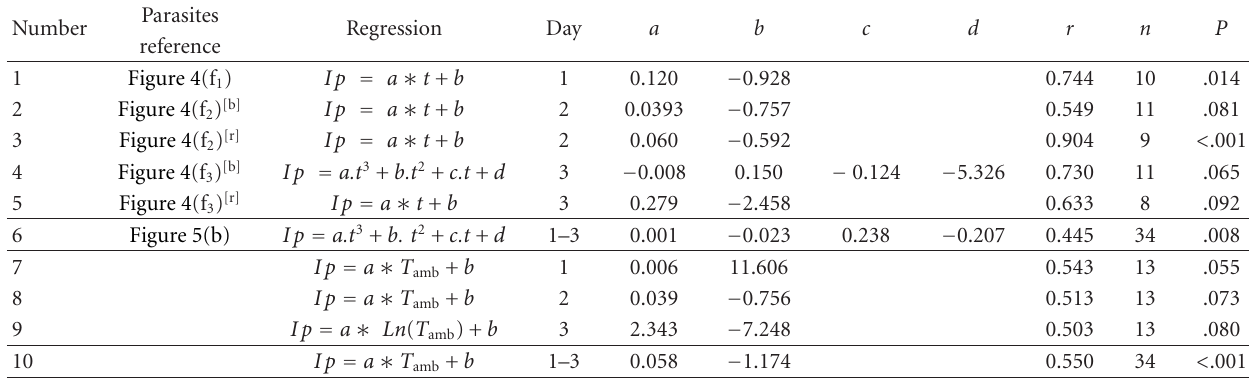
Table 2: Regression functions for the activities of parasites infesting Halictus scabiosae nests. [b][r] : black and red curves (see text). For other details see legend of Table